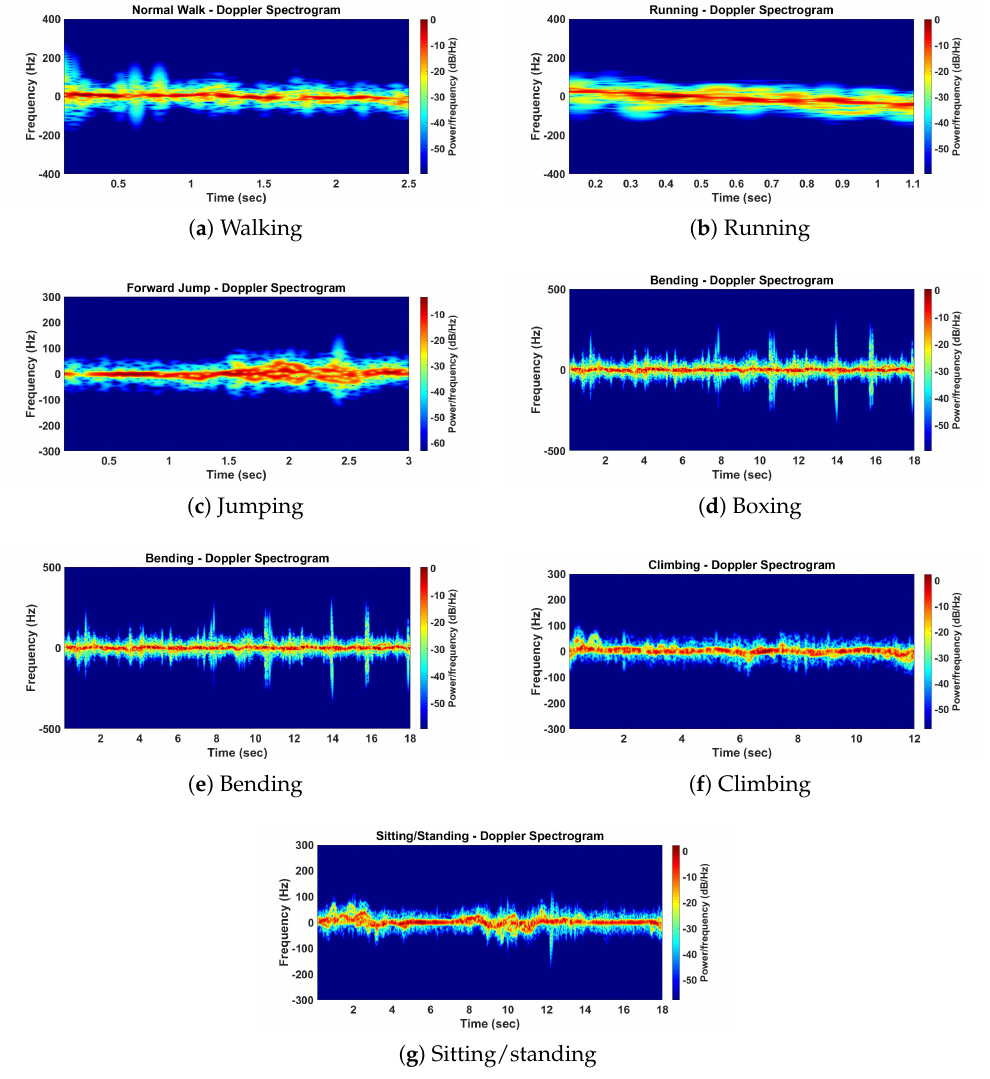
Figure 4. Micro-Doppler spectrogram (left to